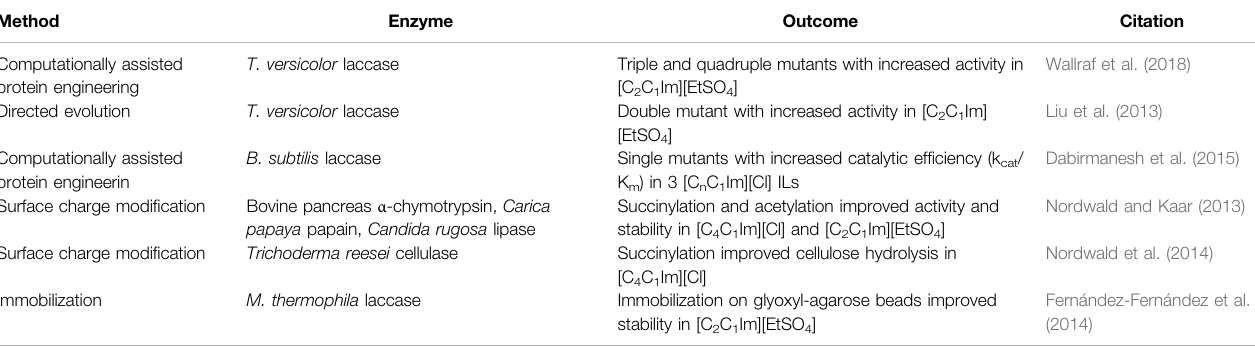
( Table 2 ). Among those, the surface modi fi cation method has